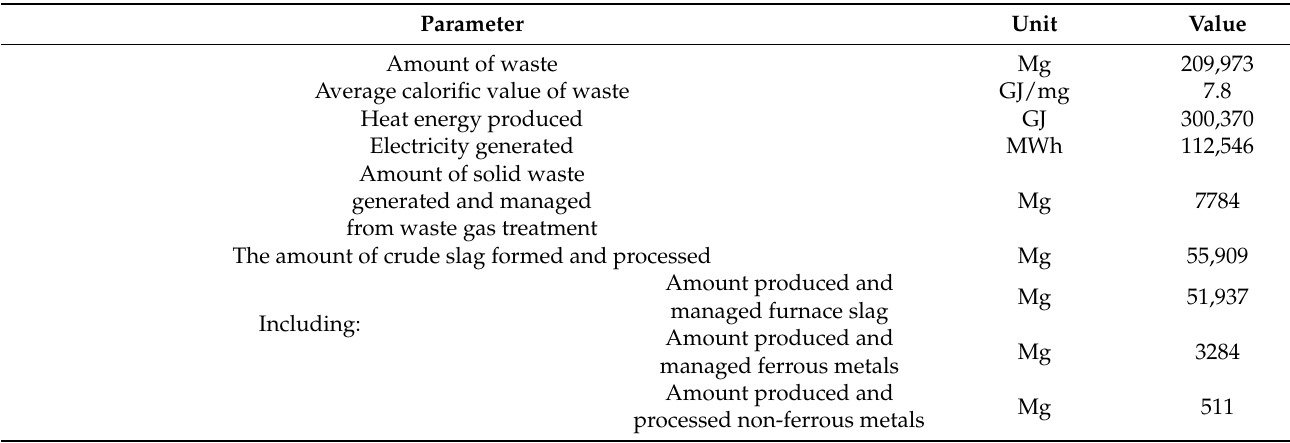
Table 3. Summary of the most important data from Poland incineration plants (year: 2018; processing capacity per year: 220,000 mg) [38].